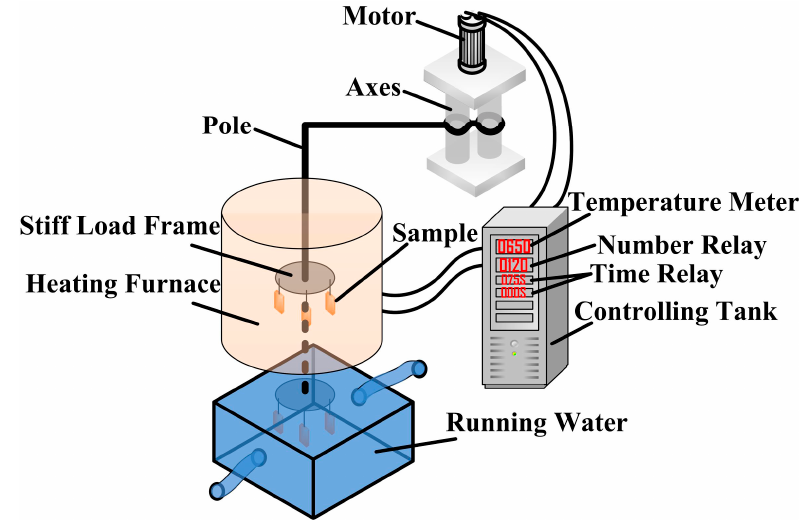
Figure 2. The schematic illustration of thermal fatigue testing rig.